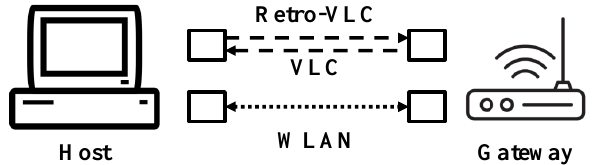
Figure 4. Architecture of heterogeneous Retro-VLC and WLAN